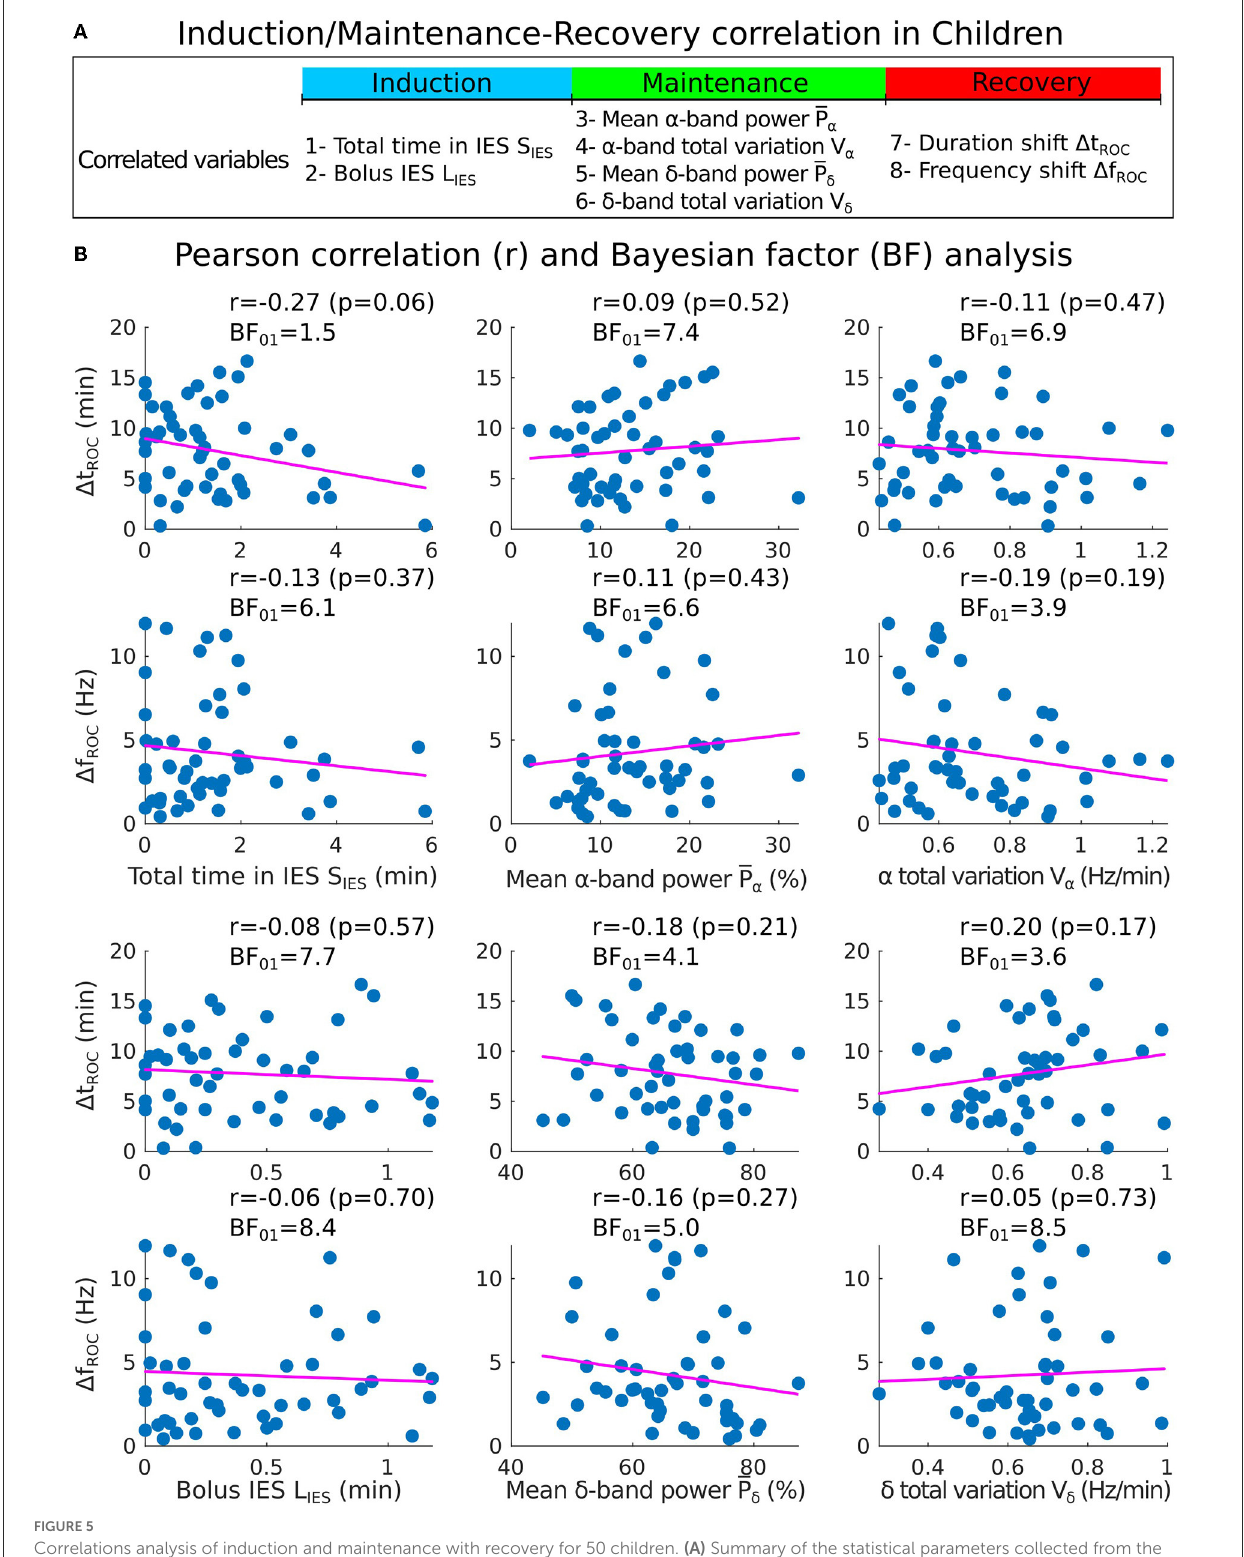
FIGURE5 Correlations analysis of induction and maintenance with recovery for 50 children. (A) Summary of the statistical parameters collected from the induction and maintenance phases (total time in IES S IES , bolus IES duration L IES , mean α − band power P α and α − band total variation V α ) and the recovery phase markers (duration shift 1 t ROC and frequency shift 1 f ROC ). (B) Scatter plots and Pearson (coefficient r , p -value p , Bayes factor BF 01 ) correlations between 1 t ROC ( 1 f ROC ) and S IES , L IES (first column), P α , P α (second column), V α , V δ (third